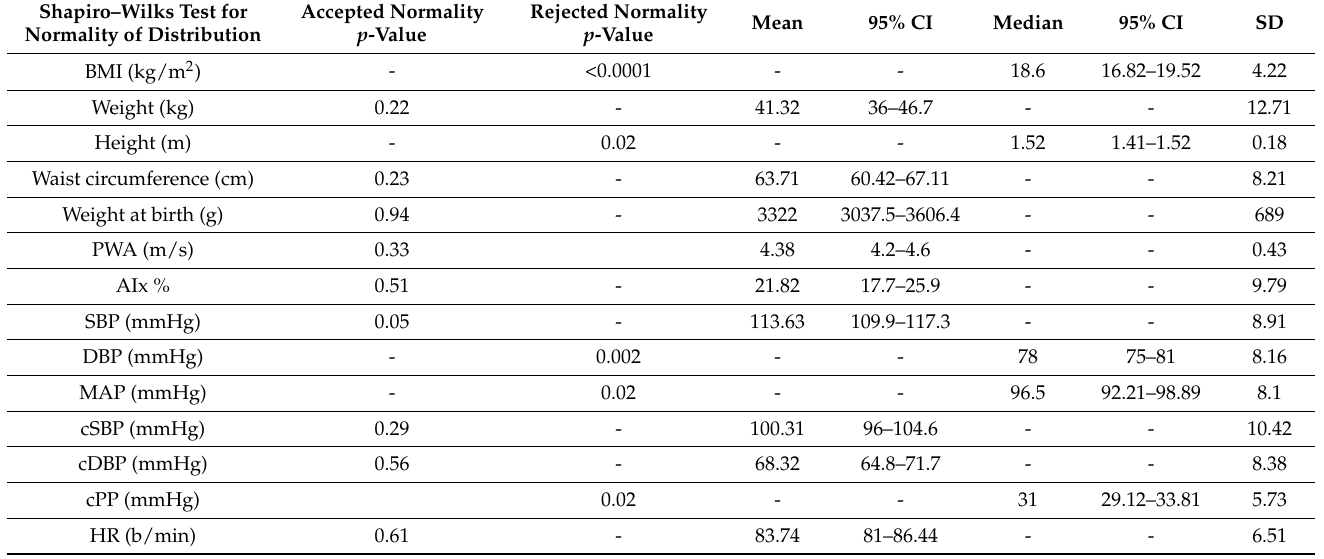
Table 2. Normality and descriptive analysis of variables in the normal-weight group ( n =